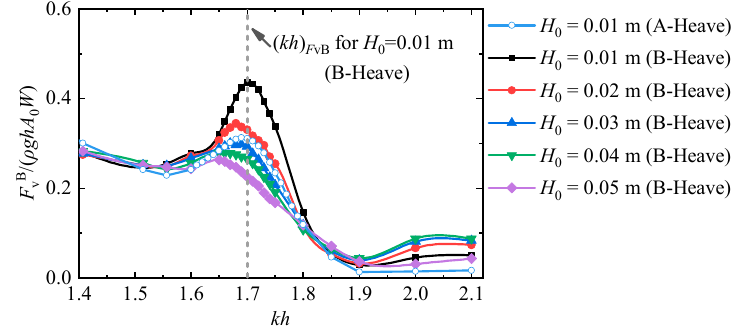
Figure 13. As in Figure 10, but for the normalized vertical wave force on Box B.